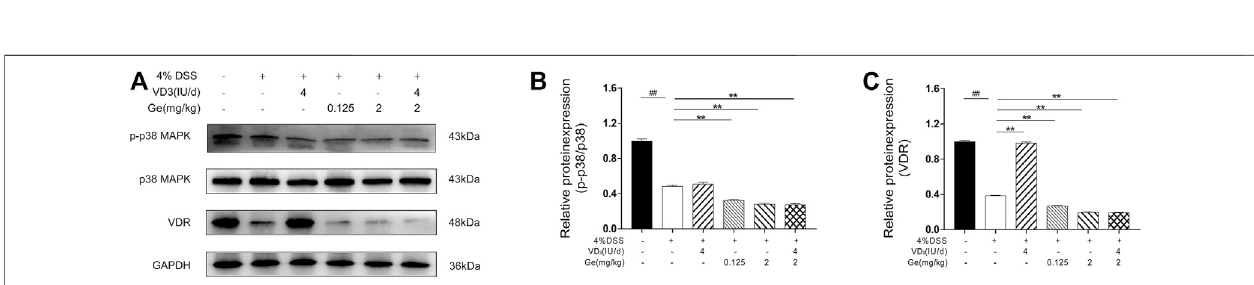
FIGURE 5 | Geniposide inhibited the expression of VDR and attenuated the simulative effect of vitamin D 3 on VDR. (A) Representative VDR expression in each group (400 × ); (B) IF intensity of VDR. ## p < 0.01, vs. the normal control group; ** p < 0.01, vs. the model control group. n (cid:1) 6 per each group.